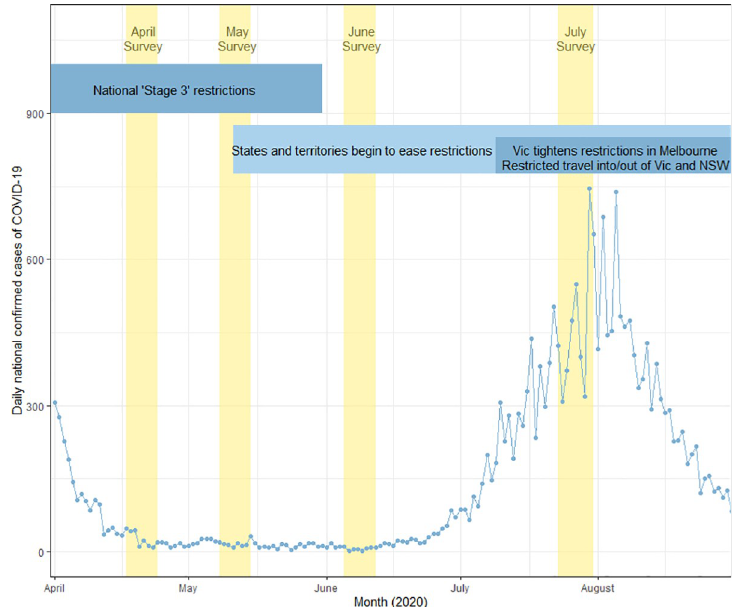
Fig 1. Summary of daily national confirmed cases of COVID-19, survey timing and government COVID-19 restrictions in Australia, April to August 2020. Vertical yellow bars indicate timespans for Surveys 1 to 4. NSW: New South Wales; VIC; Victoria. Source for national case data: covid19data.com.au.